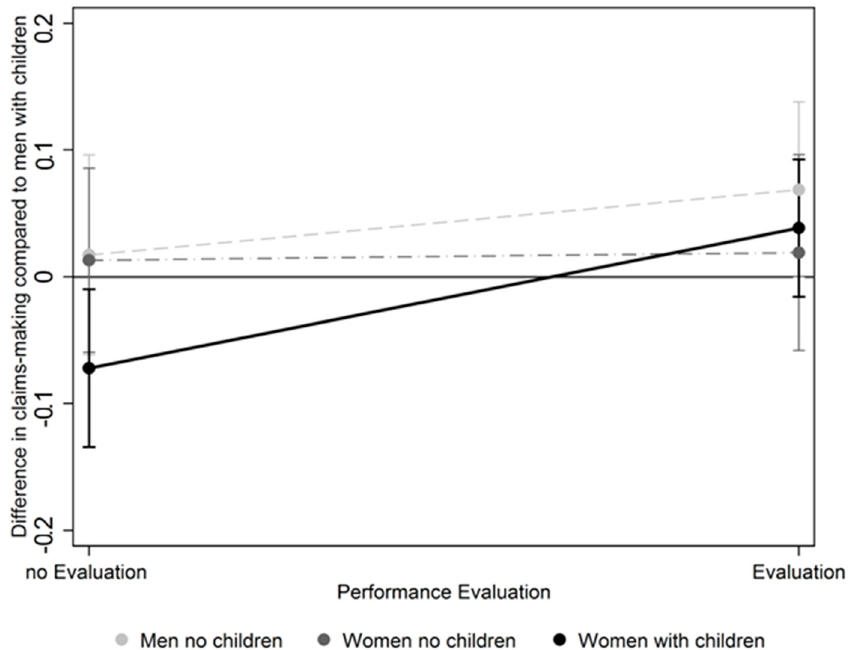
Figure 4. Gender differences in estimated values for claims-making according to performance evaluations in the workplace. Note: Based on results shown for model 1 in Table 7. The graph shows the interaction between performance evaluations and family status; reference group = men with children; 90% confidence intervals, using stata-command